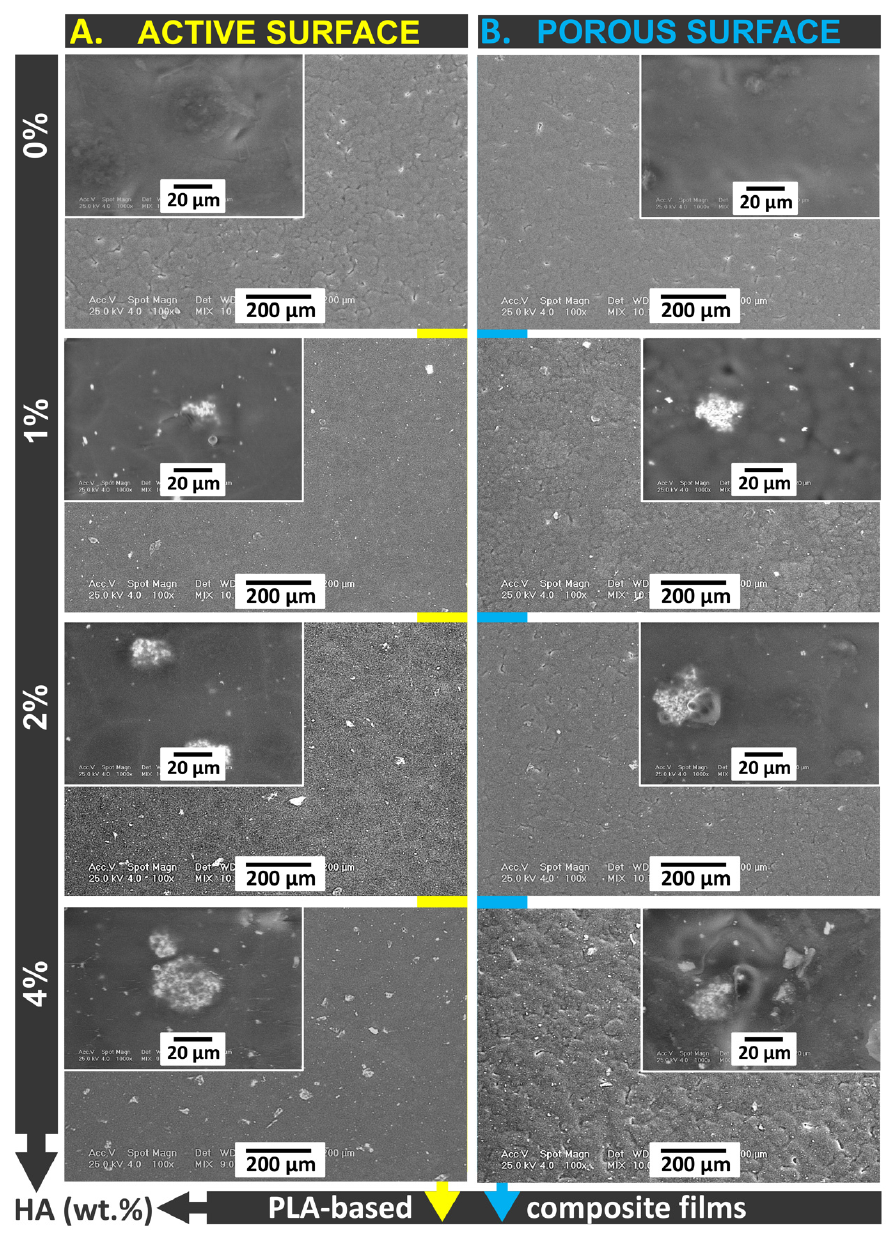
Figure 5. SEM images of PLA and PLA/HA composite films. ( A ) Active surface of the membranes, ( B ) porous surface of the films. ( B ) porous surface of the